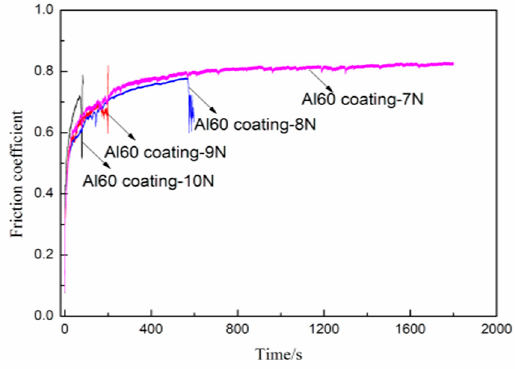
Figure 10. Friction coefficient as a function of sliding time under 7 N for PEO coatings.